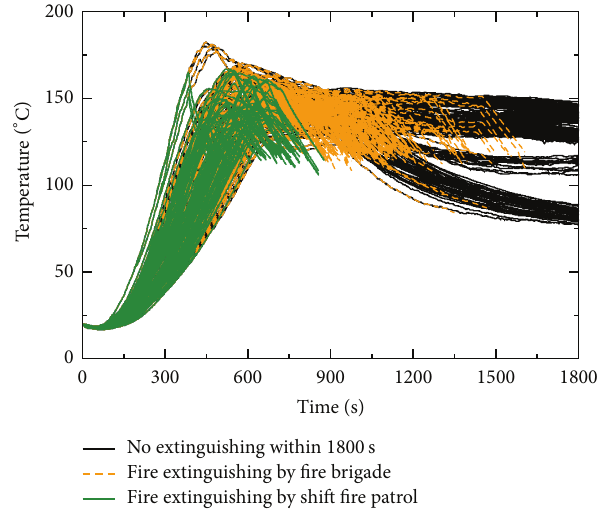
Figure 3: Temperature inside the cable jacket.